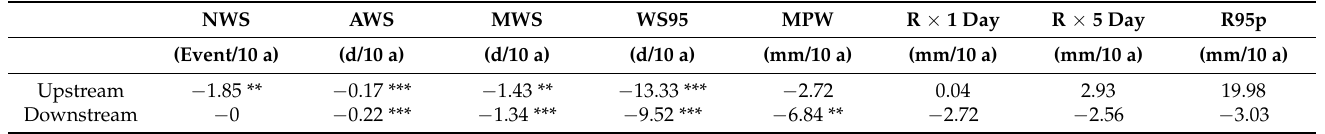
Table 7. Trends in indices, in the wet spell over the LRB during